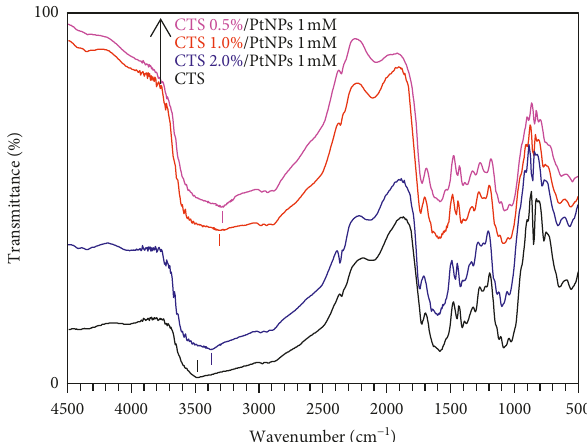
Figure 4: FT-IR spectra of CTS and PtNPs/CTS samples with different CTS concentrations.